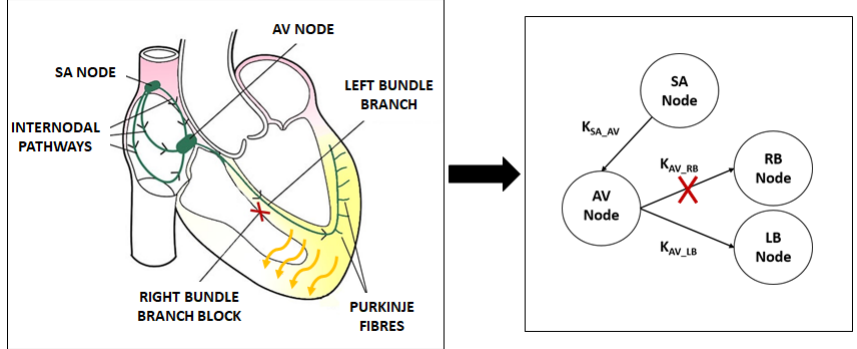
Figure 7. Right Bundle Branch Block (RBBB) and relative four coupled oscillators model.